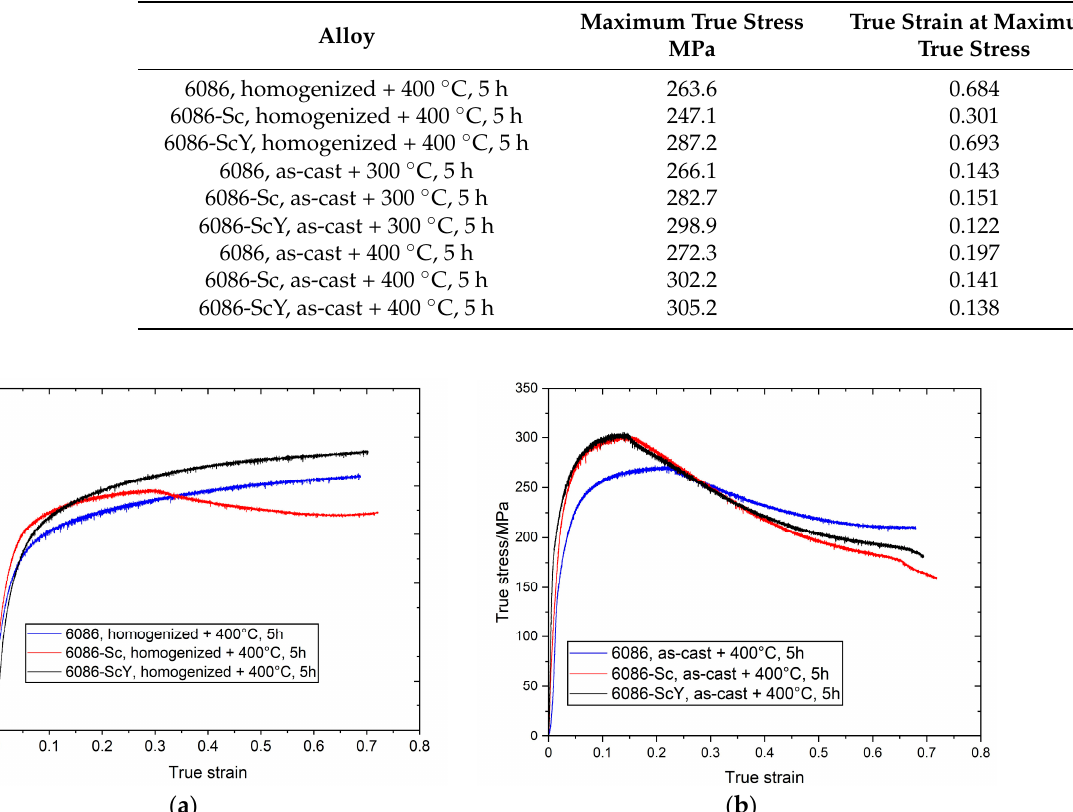
Figure 24. True stress—true strain diagrams of samples exposed to dilatometry. ( a ) After sequence simulating homogenization and isothermal heat treatment at 400 °C for 5 h; ( b ) after sequence simulating isothermal treatment of the as-cast specimens at 400 °C for 5 h.